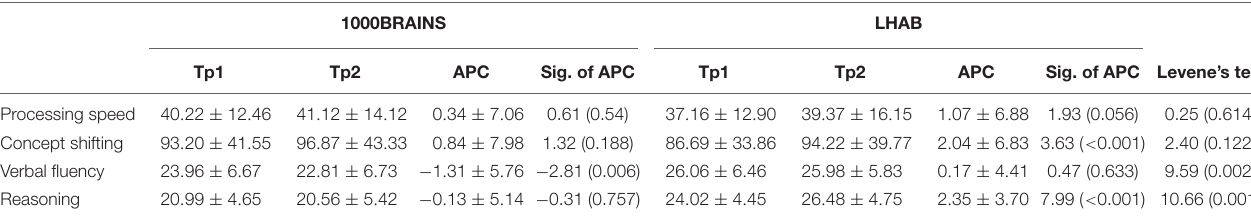
TABLE 2 | Raw cognitive performance values for TP1 and 2, as well as the APC together with T and p -values for the APC (Sig. of APC; one sample T -test) and F and p -values for sample homogeneity (Levene’s